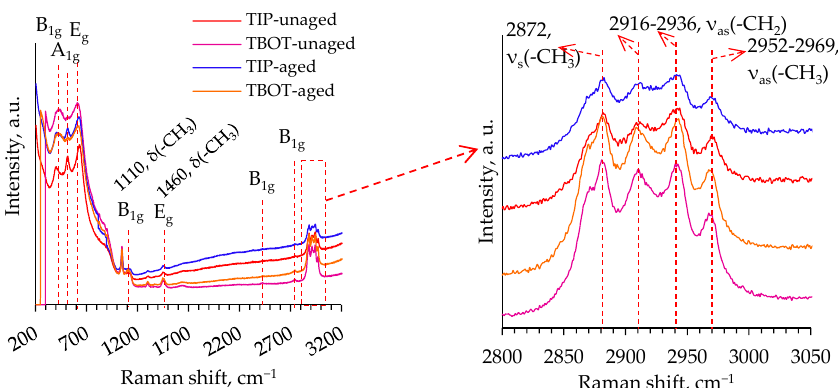
Figure 6. Raman spectra of the unaged and aged TiO 2 aerogels synthesized without an additional solvent exchange.